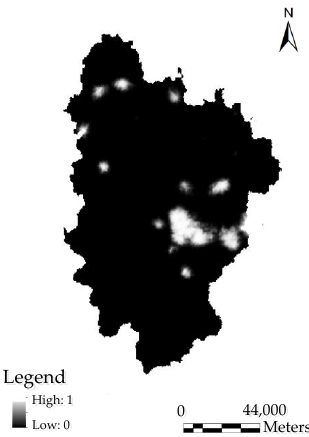
Figure 6. The probability of the overall development influenced by cellular and various